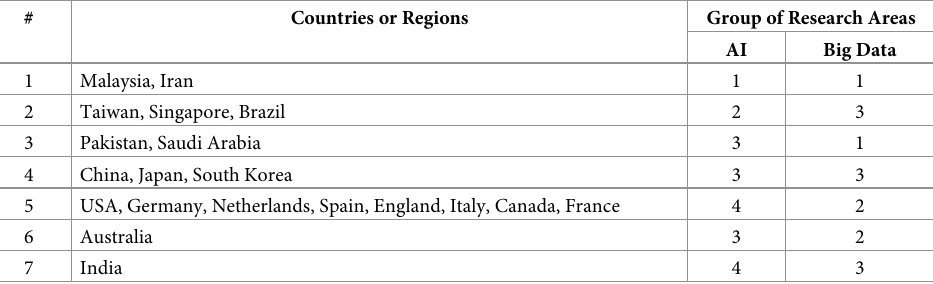
Table 7. Seven connection patterns between the author research